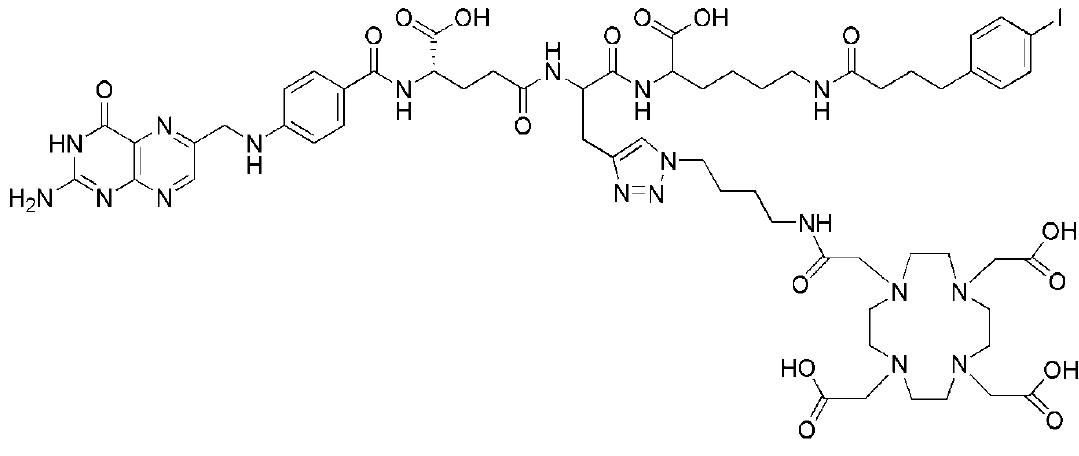
Figure 12. Chemical structure of cm09 composed of three functionalities: folic acid acts as a targeting agent for FR-specific uptake in the tumor tissue; a DOTA-chelator is needed for stable coordination of trivalent radiometals (e.g., 152 Tb, 44 Sc); a small molecular weight albumin binding entity is responsible for an enhanced circulation time of the radioconjugate in the